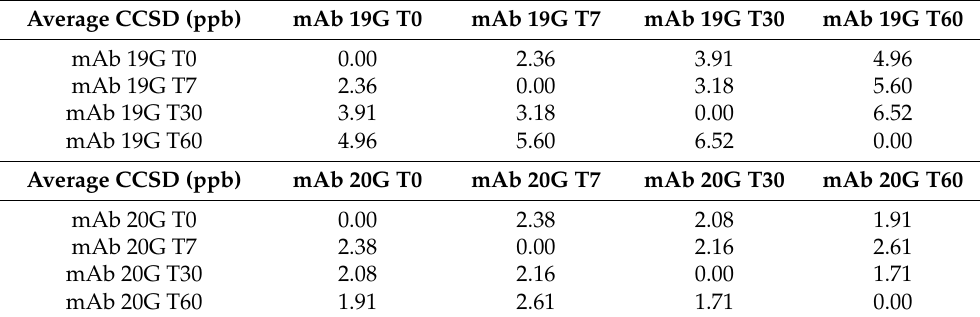
Table 1. Average combined chemical shift differences.